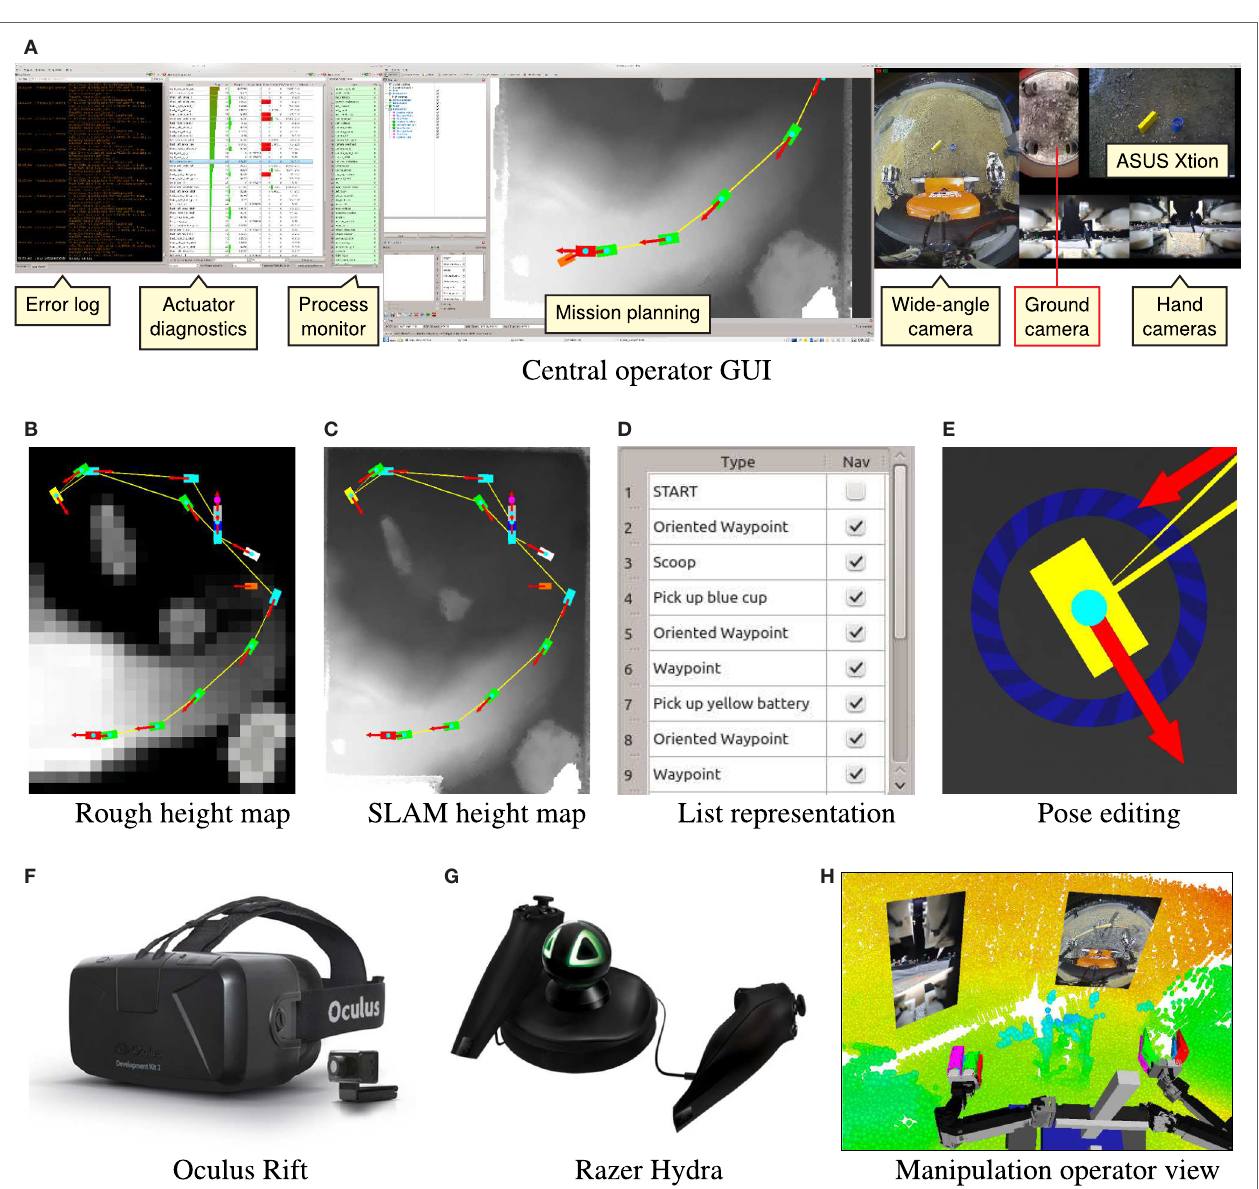
FIGURE 11 | Operator interfaces . (A) Overview of the GUI shown on the three lower screens of the main ground station. The left, center, and right screens are dedicated to system monitoring and diagnosis, mission planning, and camera images, respectively. (B) Mission plan on rough height map provided by DLR. (C) Mission plan on detailed height map generated from the SLAM map. (D) List representation of the first 8 poses. The “Nav” column can be used to disable navigation (e.g., start grasping an object immediately). (E) Pose editing using interactive marker controls. The position can be modified by dragging the rectangle. The pose is rotated by dragging on the blue circle. Teleoperation interfaces: operator uses (F) , oculus rift DK2 HMD, and (G) Razer Hydra 6 DOF controllers for immersive teleoperation. (H) 3rd person view of the scene rendered in the Oculus HMD during debris cleaning (see Figure 13 ).